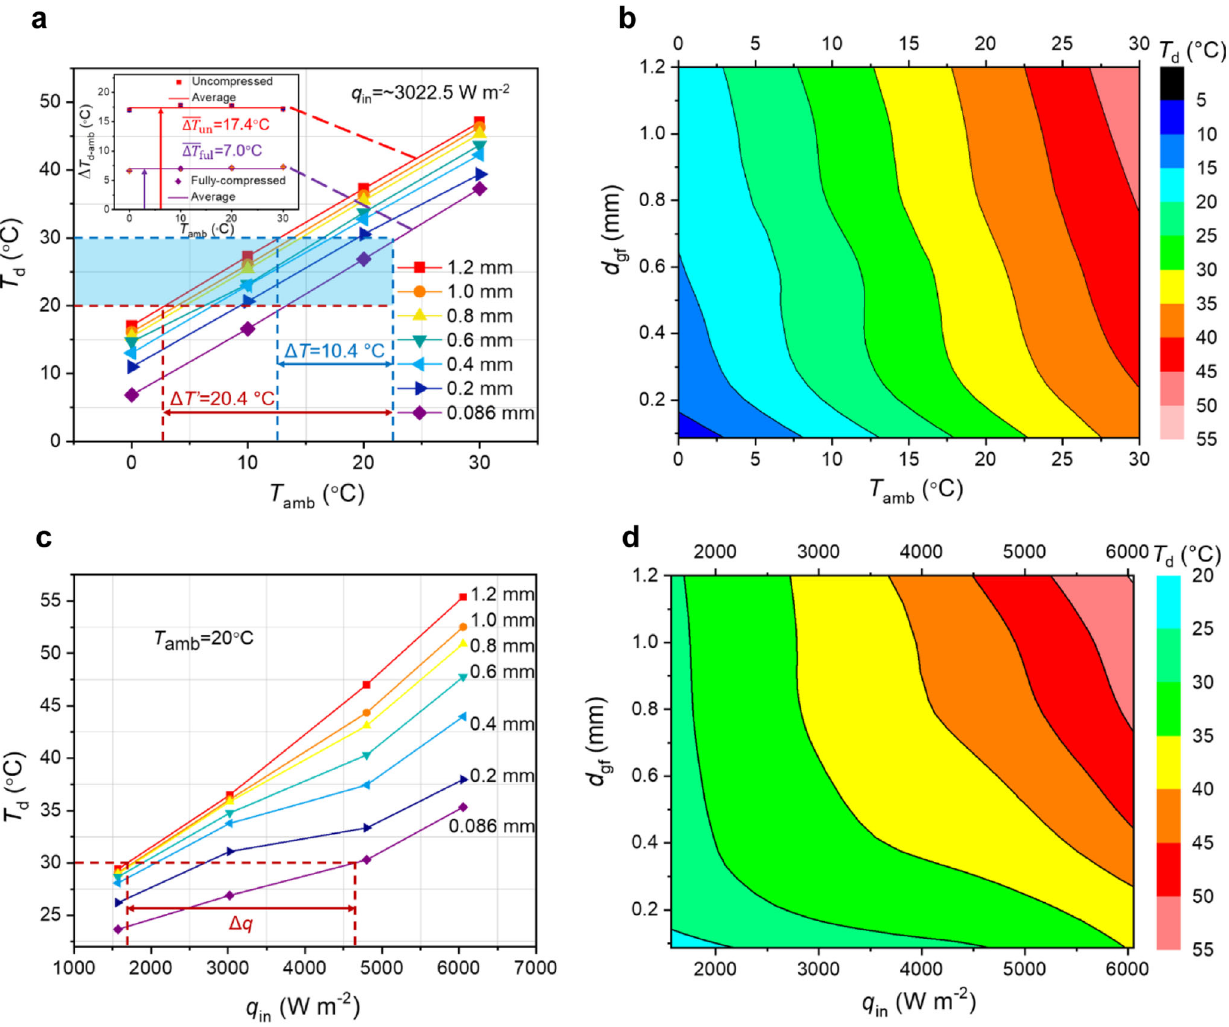
Fig. 5 Performance as both a thermal regulator and a thermal switch. a Device temperature as a function of ambient temperature at each thickness of graphene foam, for a constant heat fl ux. The temperature difference between device and environment at the uncompressed and fully compressed states are 17.4 °C and 7.0 °C, respectively, resulting in a switching ratio of ~2.5. The temperature window over which the device temperature can be controlled is ~10 °C from the minimum to maximum T d at each ambient temperature level at this heat fl ux (the range illustrated by the blue dashed line) and can be extended to 20.4 °C (the range between the brown and the blue dashed lines) when the operating temperature is a range from 20 °C to 30 °C (displayed by the blue shade). b Contour plot showing the capacity of graphene foam for continuous temperature regulation with varying ambient temperatures. To achieve a constant device temperature, the thickness of the graphene foam, d gf, should be adjusted following one of the isotherms as the ambient temperature is varied. c Device temperature as a function of the heat fl ux at different thicknesses of the graphene foam. d Contour plot showing the capacity of graphene foam for continuous regulation based on heat load. To maintain a particular device temperature above the ambient temperature, the thickness of the graphene foam can be controlled following the isotherms as the input heat fl ux is